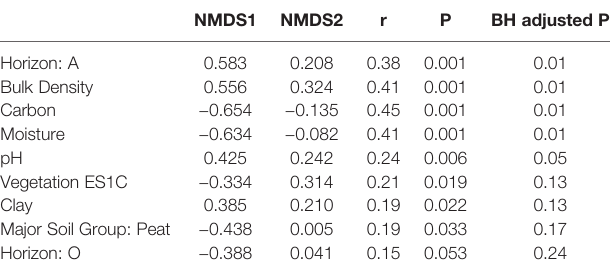
TABLE 2 | Environmental variables with a statistically signi fi cant relationship to Pasteuria spp. community ordination before or after Benjamini-Hochberg correction.